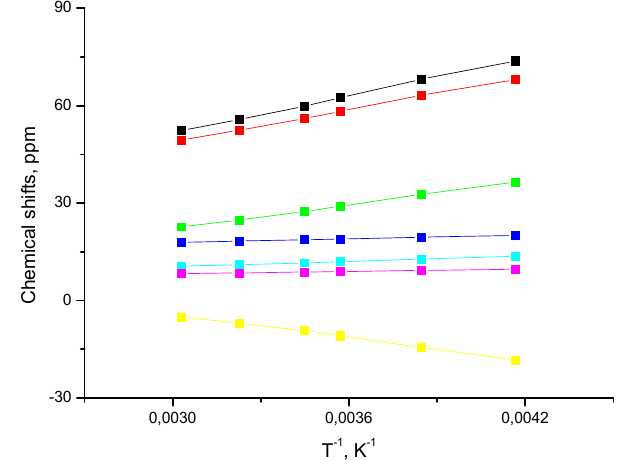
Figure 2. 1 H chemical shifts of Fe( L1 ) 2 OTf 2 in an acetonitrile-d 3 solution plotted versus 1/ T ; for Fe( L2 ) 2 OTf 2 and Fe( L2 ) 2 (BF 4 ) 2 , see Figure S2. The solid lines represent linear fits.